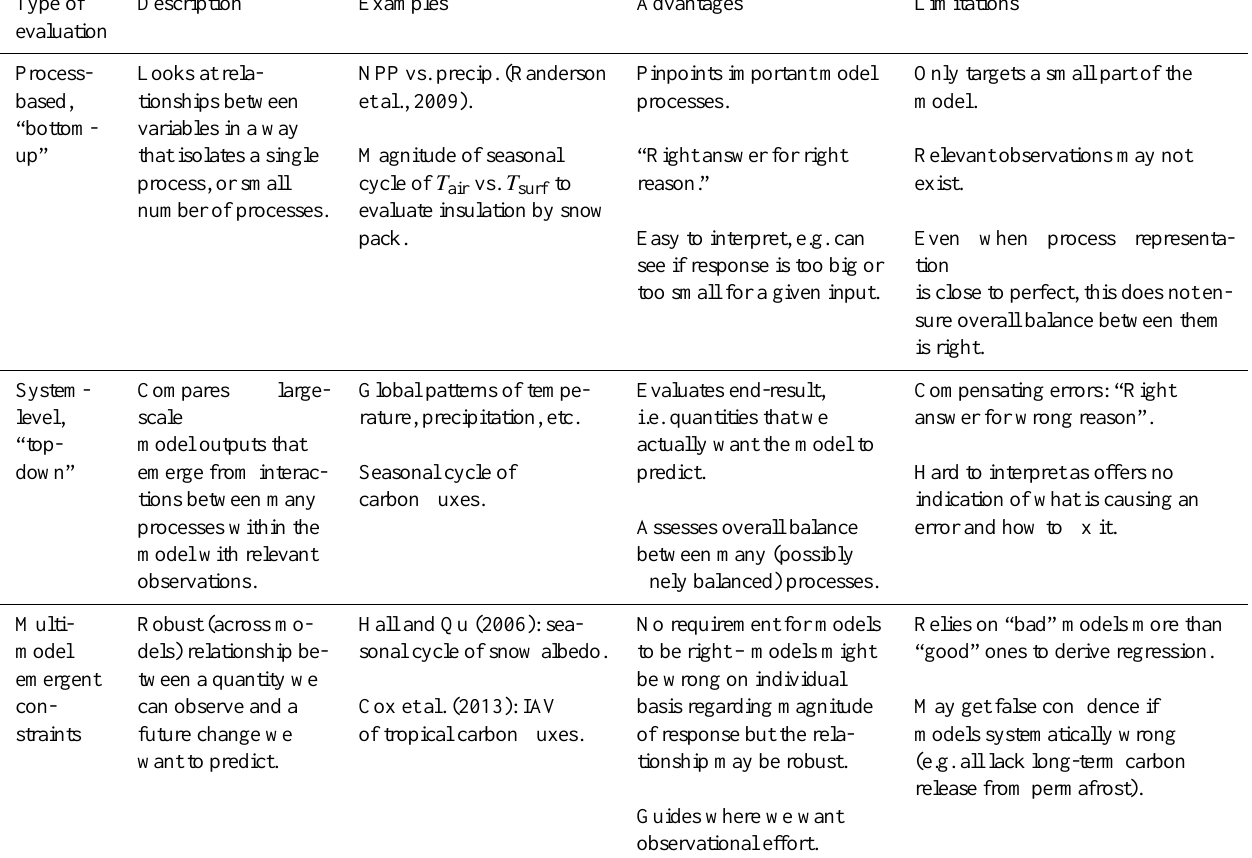
Table 5. Summary of evaluation